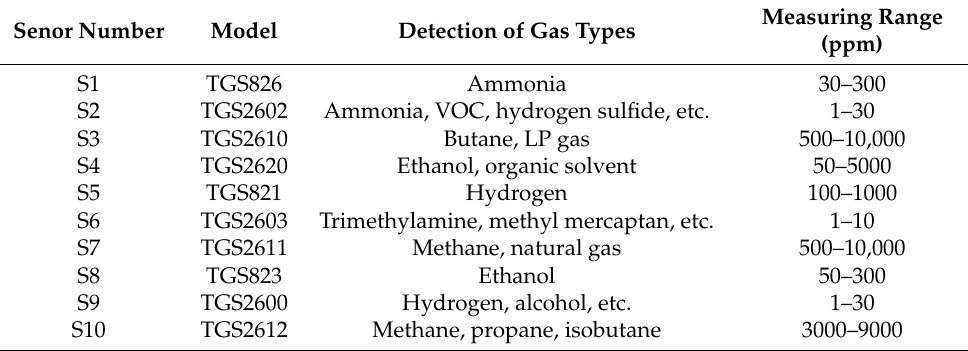
Figure 3. SOM content detection system based on pyrolysis and electronic nose. Table 1. Gas sensor model and parameters.